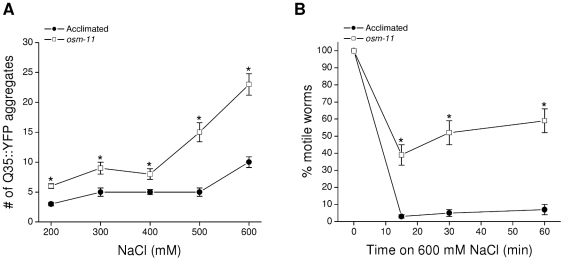
Effect of elevated glycerol levels on hypertonic stress-induced aggregation of Q35::YFP.
A: Aggregation of Q35::YFP measured after a 24 h exposure of osm-11 or acclimated worms to media containing 200–600 mM NaCl. (n = 13–15). *P<0.01 compared to acclimated animals. B: Time course of motility changes in osm-11 and acclimated worms exposed to 600 mM NaCl. Acclimated worms become paralyzed within 10–15 min due to water loss. osm-11 mutants lose less water due to elevated glycerol levels (see Figure 1A) and therefore remain motile compared to acclimated worms. (n = 13–21). *P<0.0001 compared to acclimated animals.